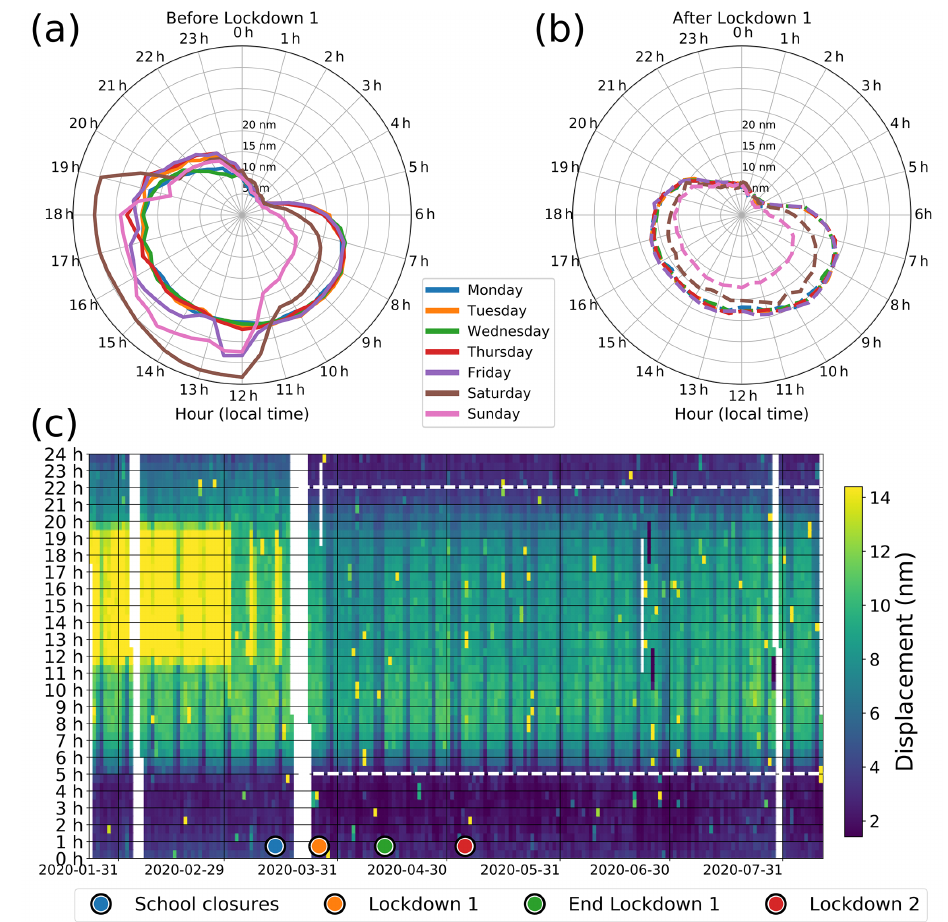
Figure 4. Analysis of station MT18 in downtown Santiago. (a, b) Clock plots showing an average of the displacement variability for each day of the week for the period (a) before Lockdown 1 (period 23 January–25 March 2020) and (b) after Lockdown 1 (period 26 March–10 August 2020) at station MT18 in downtown Santiago. (c) Displacement noise evolution is shown in an hourly grid representation. Gaps correspond to periods for which seismic data are unavailable. Blue, orange, green, and red circles below represent the time of public restrictions implemented in downtown Santiago. Horizontal dashed white lines show the curfew period imposed between